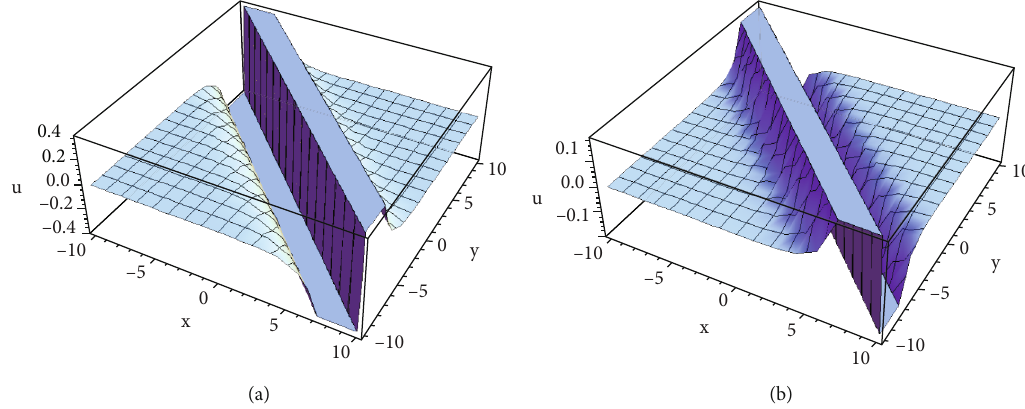
Figure 4: The outline of the bright-dark soliton. (a) for Eq.(38) and (b) for Eq.(39).